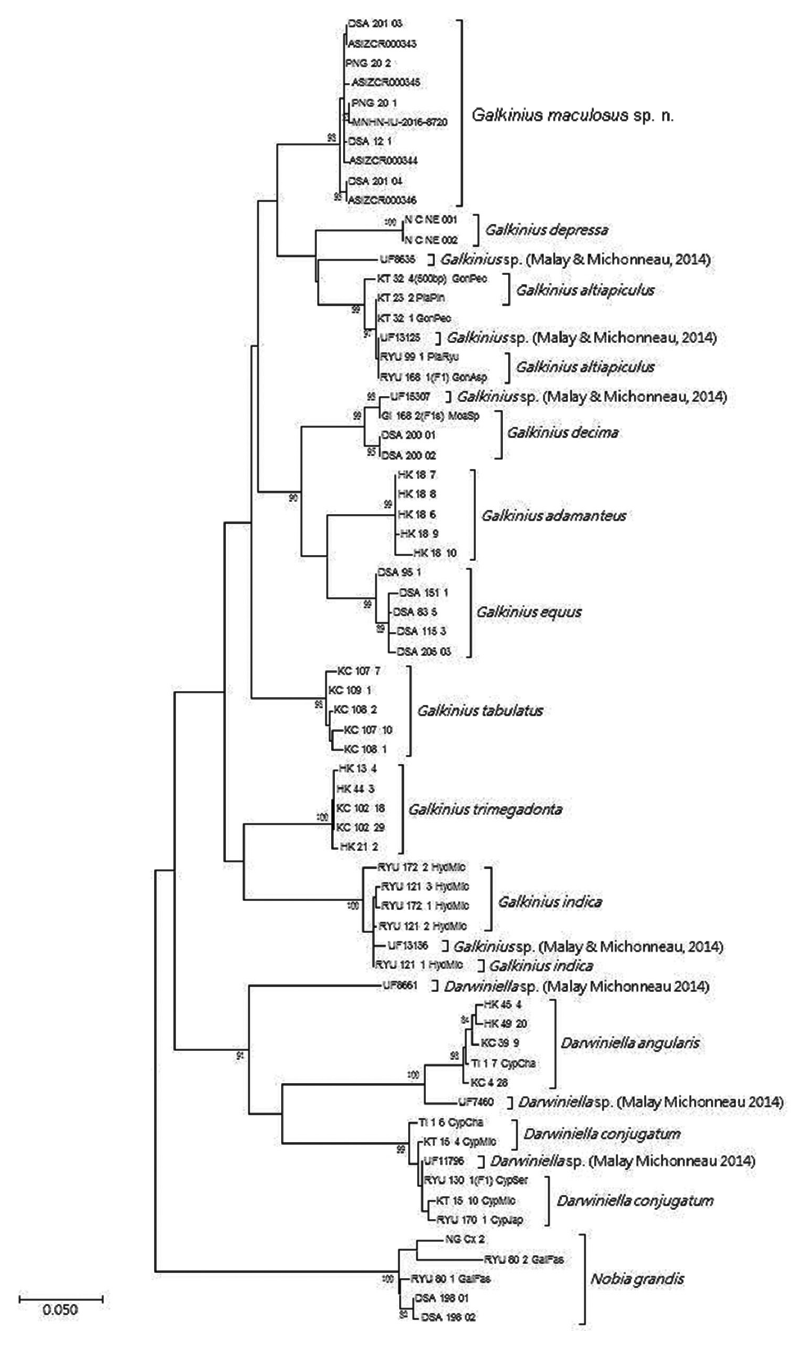
Figure 10. Maximum Likelihood (ML) method inferred genealogical relationships of Darwiniella and Galkinius specimens based on 624bp 12S and COI with Nobia grandis as the outgroup. Numbers above the major nodes are bootstrap values of 1000